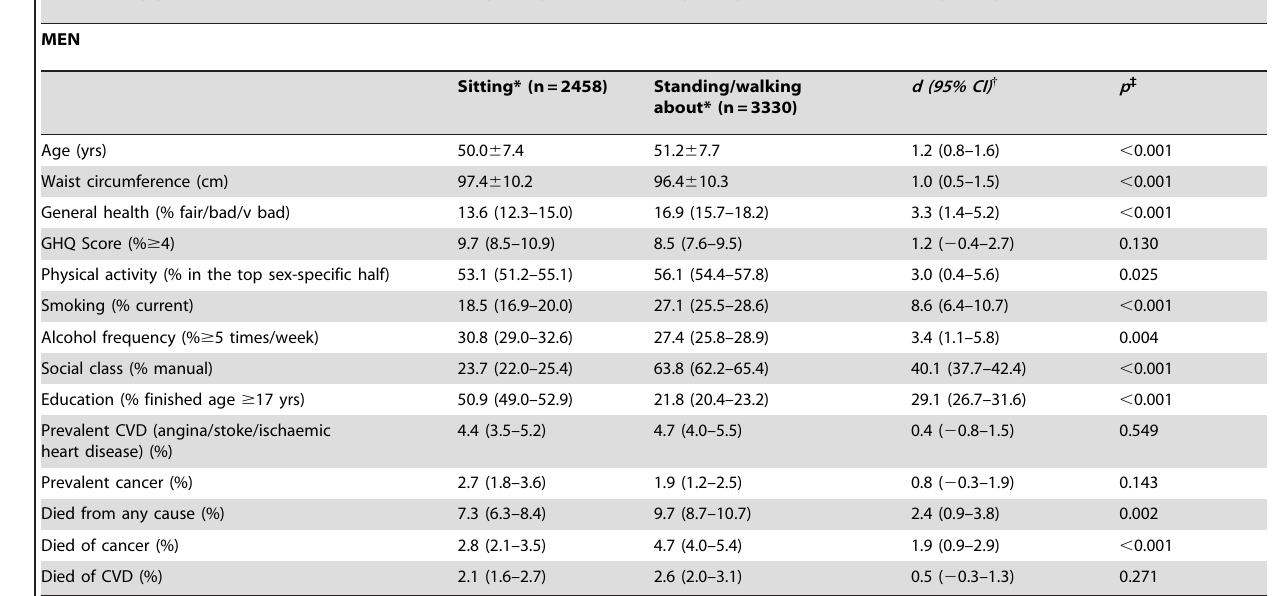
cardiovascular deaths) who were followed up for three years or more. The direction and magnitude of the observed associations